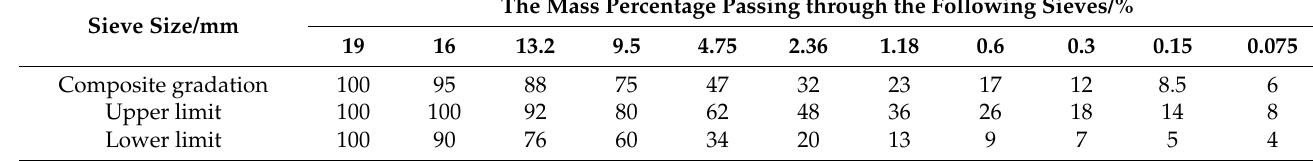
Table 1. The gradation of AC-16 in this